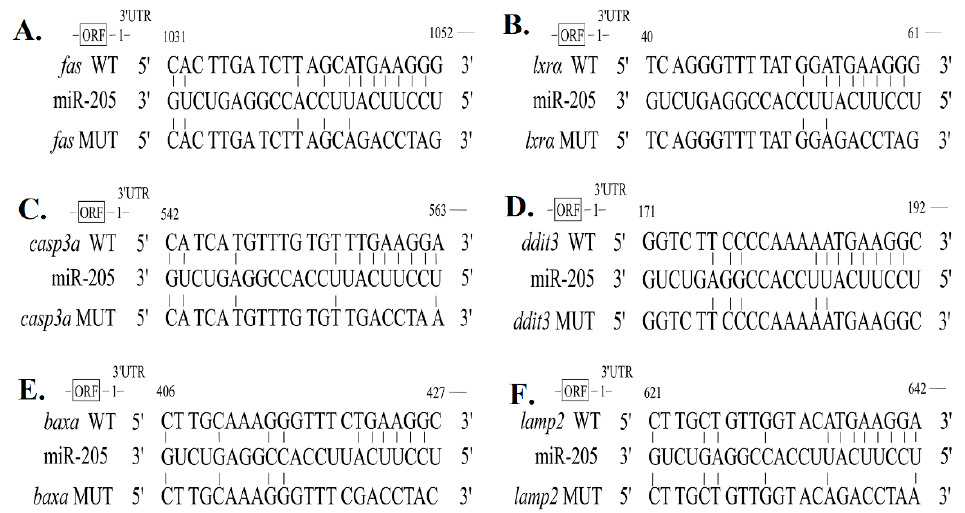
Figure 4. Schematic representation of the miR-205 target sequence within the 3 ′ UTR of fas , lxr α , ddit3 , casp3a , baxa and lamp2 . ( A – F ) The binding sites of miR-205 with fas , lxr α , ddit3 , casp3a , baxa , and lamp2 3 ′ UTR. “|” indicates nucleotides that are reversely complementary to miR-205. Six nucleotides (complementary to nucleotides 2–7 of miR-205) were mutated to “GACCTA” in the 3 ′ UTR of fas , lxr α , ddit3 , casp3a , baxa and lamp2 . The numbers indicate the positions of the nucleotides in the reference wild-type sequences.